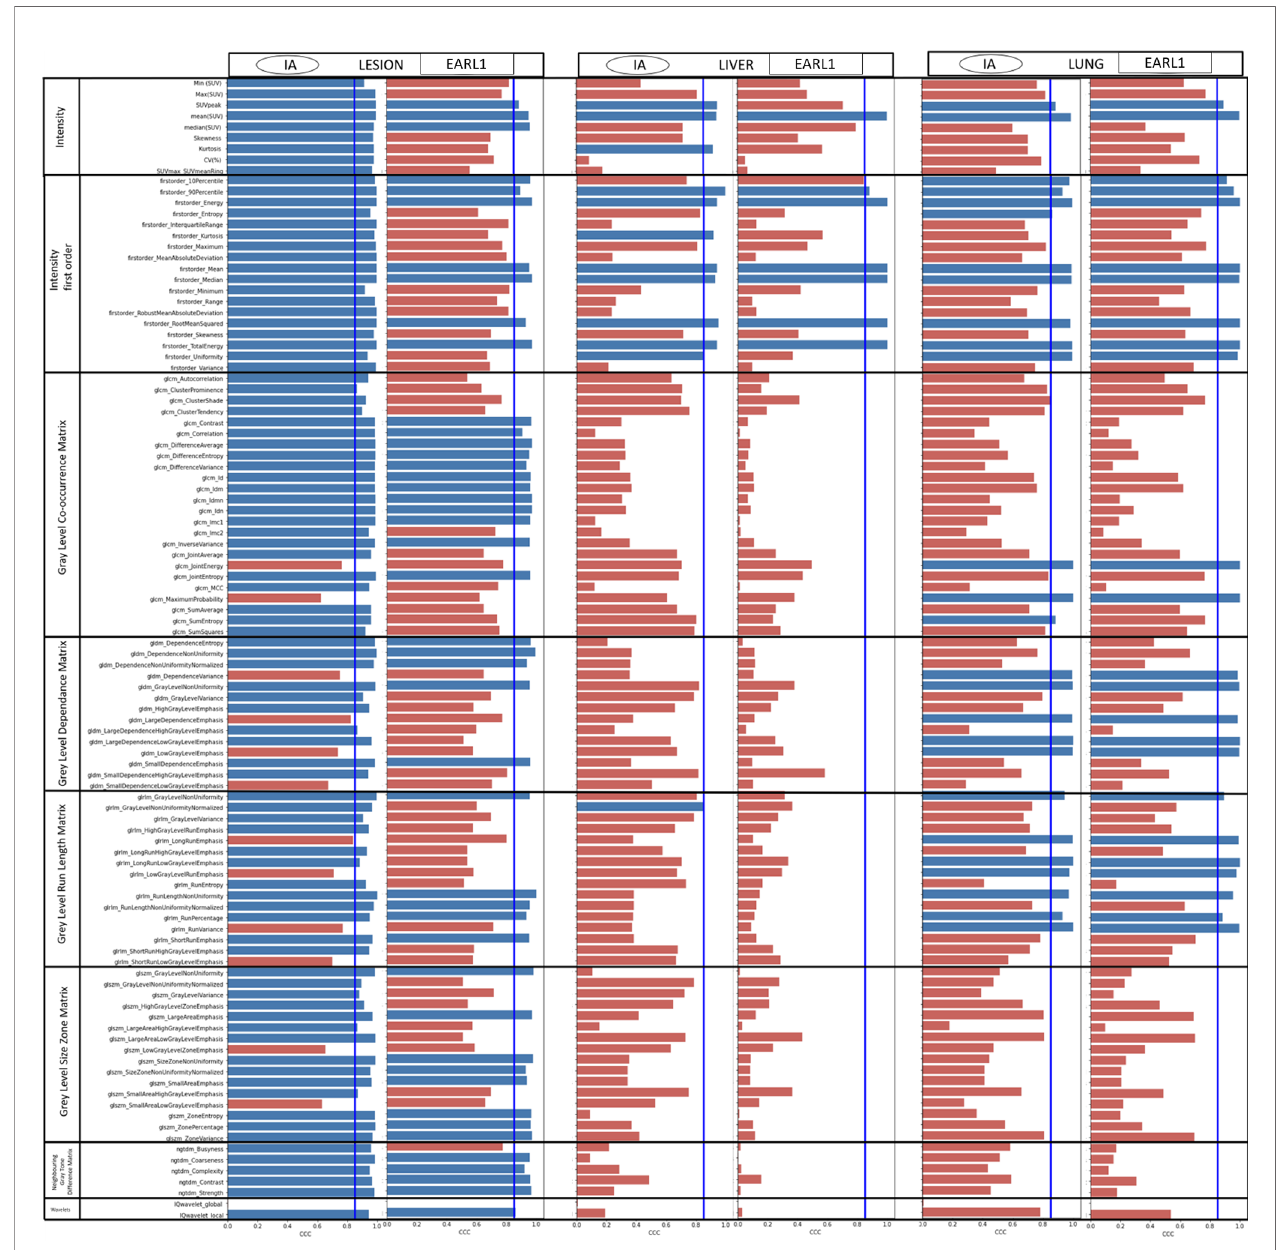
FIGURE 2 | CCC of all the features from AI and EARL versus original images. A threshold is display by a line with a CCC = 0.85. Blue bar indicates a CCC ≥ 0.85, red bar CCC <